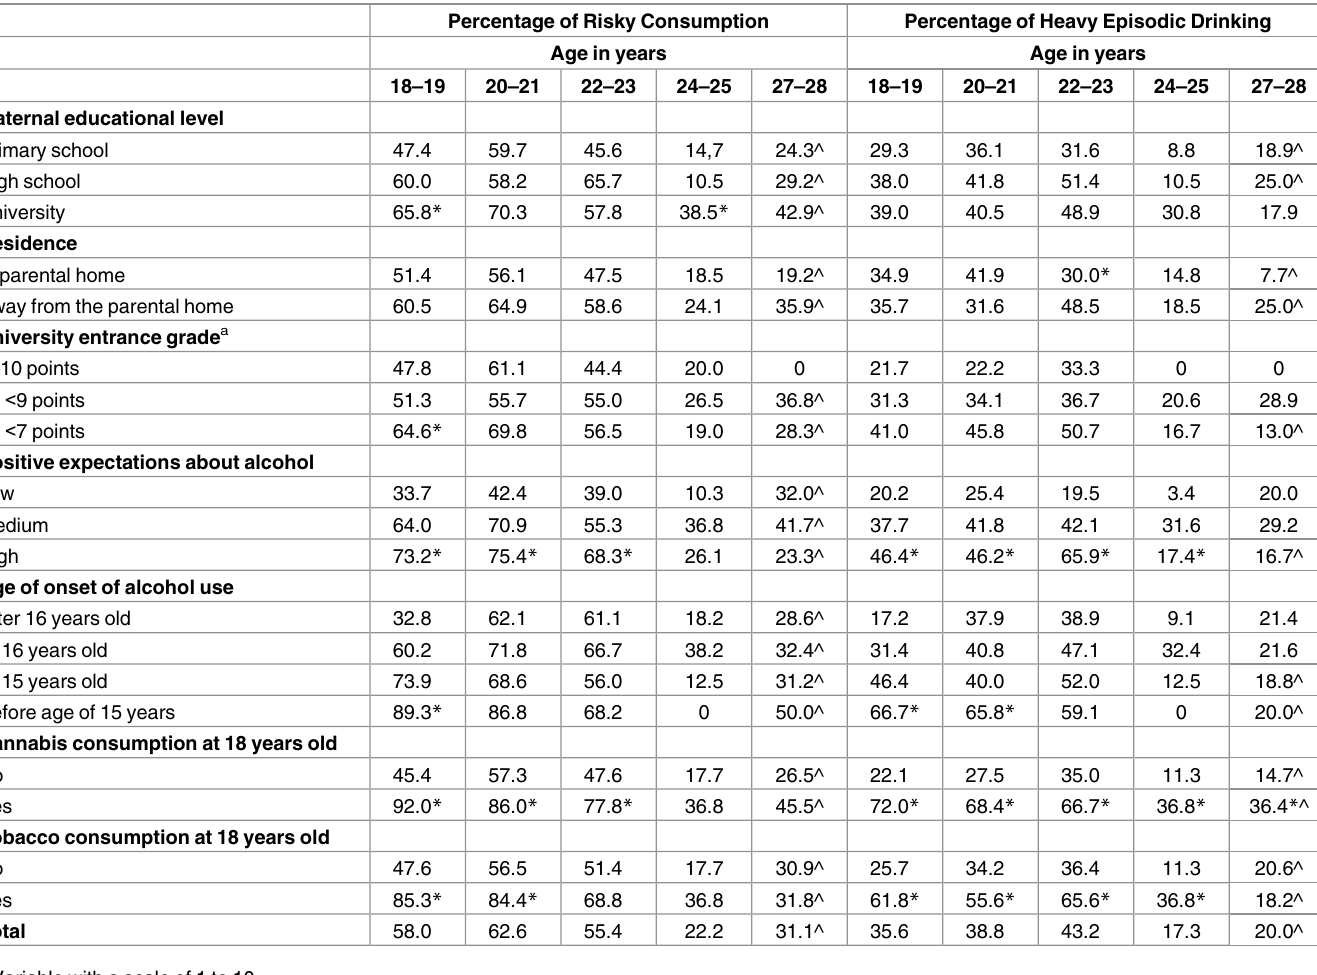
Table 4. Main characteristics of the male subjects and alcohol consumption at ages 18, 20, 22, 24 and 27